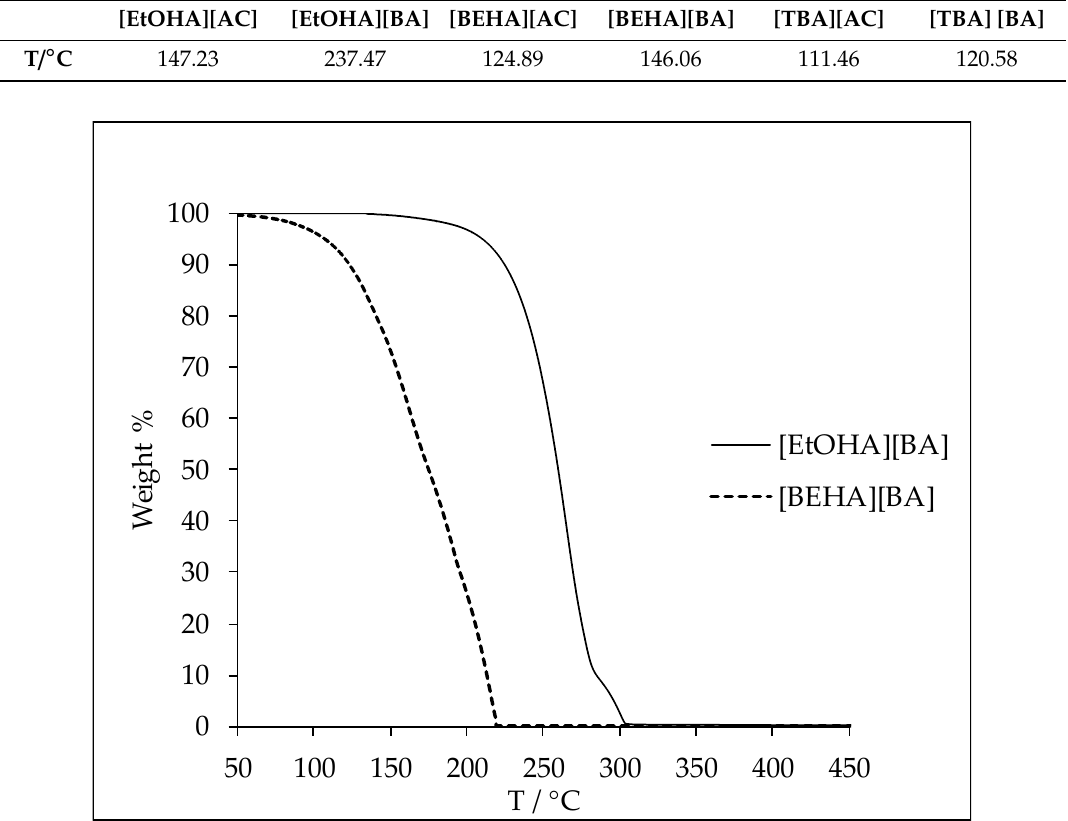
Table 8. Thermal decomposition ( T d ) temperature of the ionic liquids.